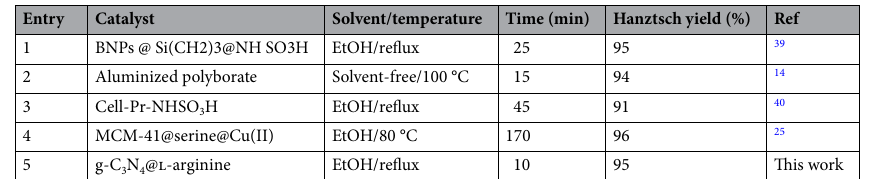
Table 6. Comparison of catalytic activity of g-C 3 N 4 @l-arginine with other reported catalysts for the synthesis of 1,4-dihydropyridine derivatives . Reaction conditions: Reaction of benzaldehyde (1 mmol),